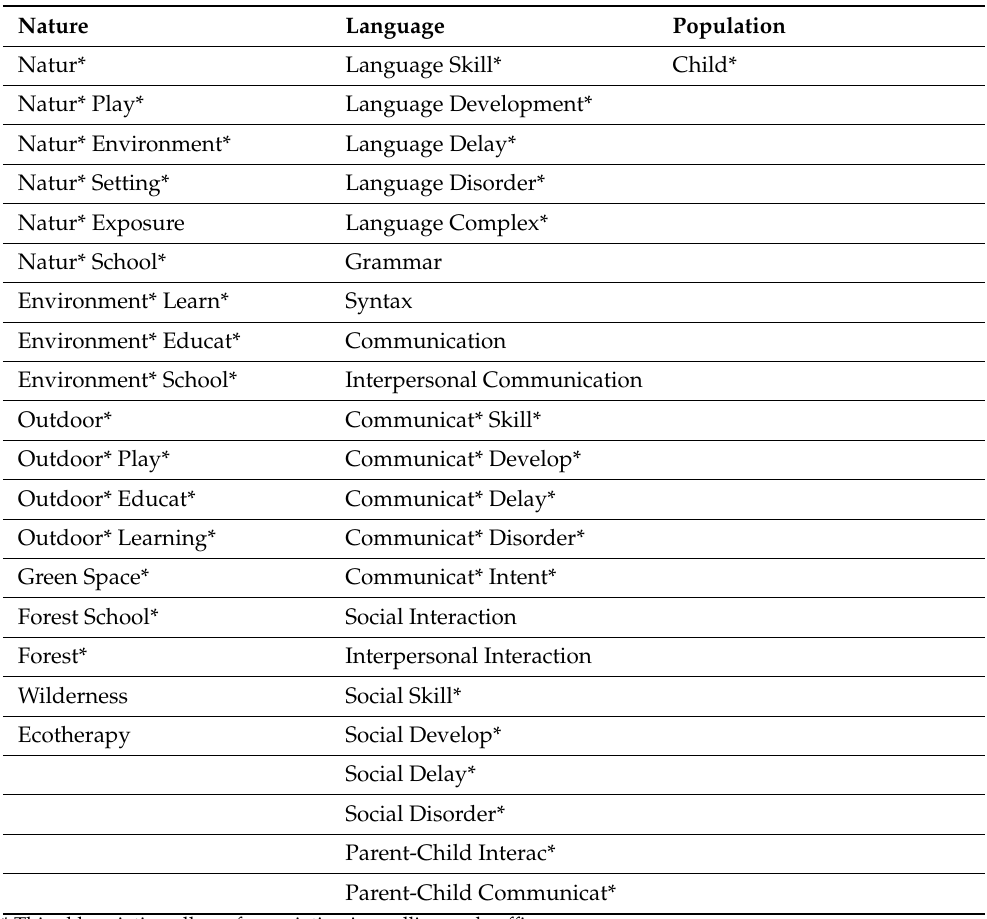
Search Terms: Table 2 contains the search teams organised into three headings: Nature, Language and Population. Table 2. Search